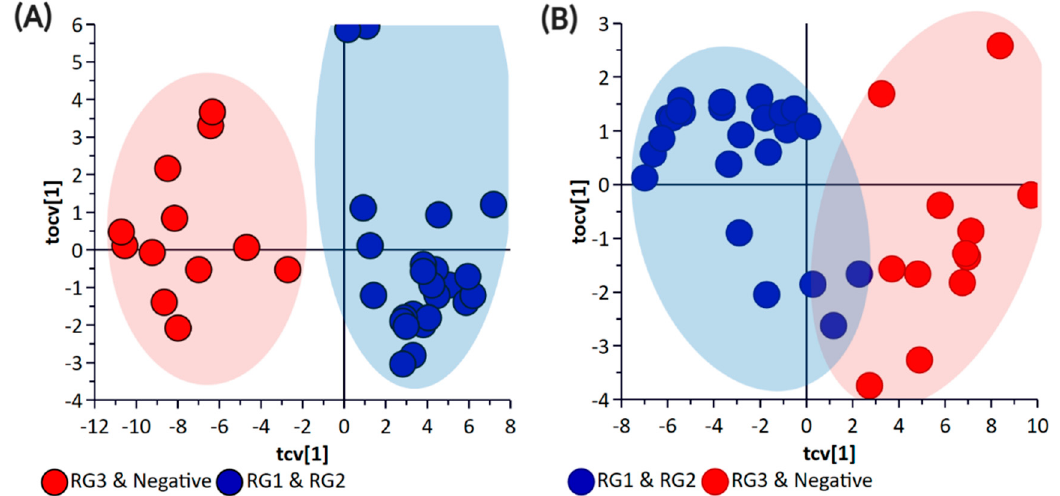
Figure 4. OPLS-DA Cross-Validation Scores plots for ( A ) bacterial pellet and ( B ) bacterial supernatant samples collected from BPW cultures ( n = 36; note, the negative group includes Salmonella). The F -test statistic and p -Value based on a CV-ANOVA were 18.12 and <0.0001 for the pellet samples, and 5.78 and <0.0002 for the supernatant samples, respectively. Note: The colored circles in each panel represent each analyzed sample, and any overlap of the deviation of the samples from the origin (0,0) indicates the potential of the model to misclassify sample groupings.